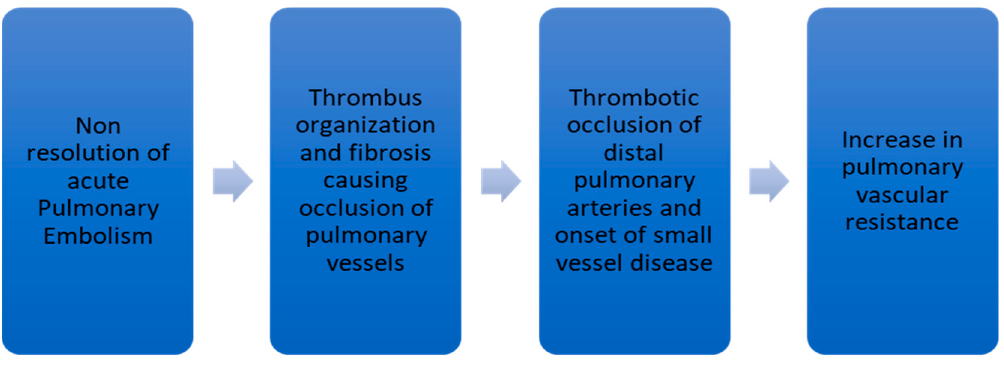
Figure 1. Flow diagram showing the pathophysiology of CTEPH.